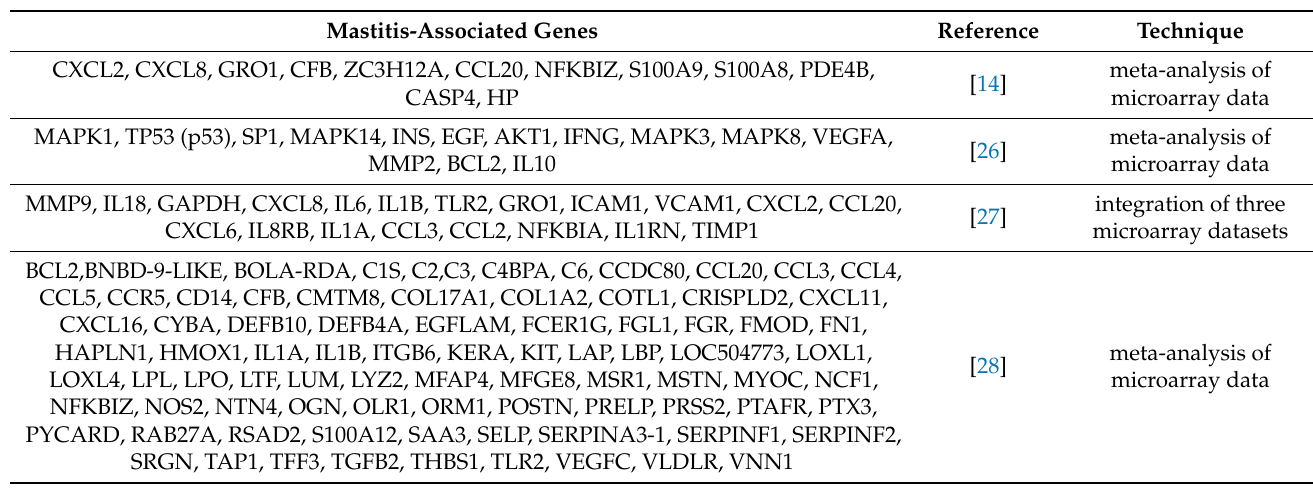
Table 2. The key genes or regulators with robust bio-signatures in response to E. coli mastitis reported in previous meta-analysis-based transcriptome studies.